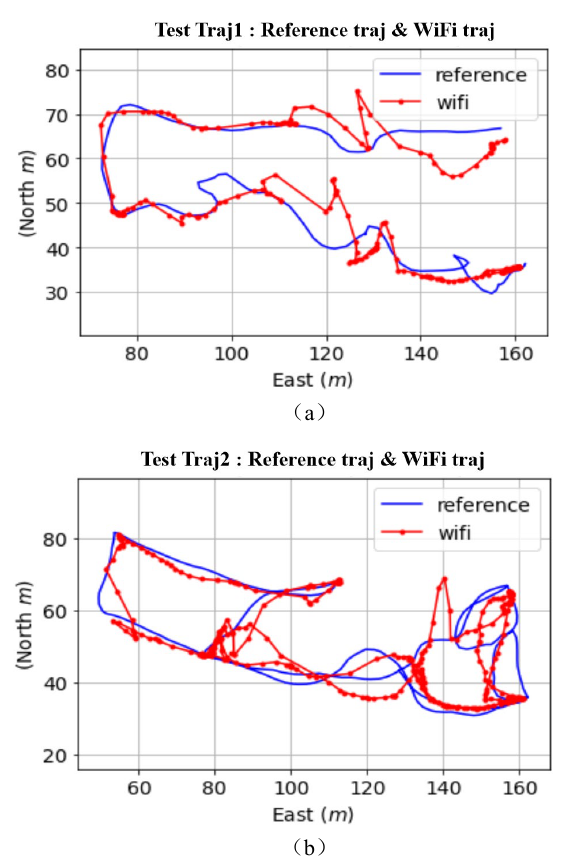
Figure 9 . WiFi Positioning Results and Reference Truth. (a) and (b) are the data of testing routes 1 and 2 respectively Perform the time-interpolation between the reference value and the real-time WiFi positioning value of the navigation track of the test track routes 1 and 2, and calculate the difference between the two positions as the positioning error time series and statistical results are shown in Figure 10 and Table 5, respectively.